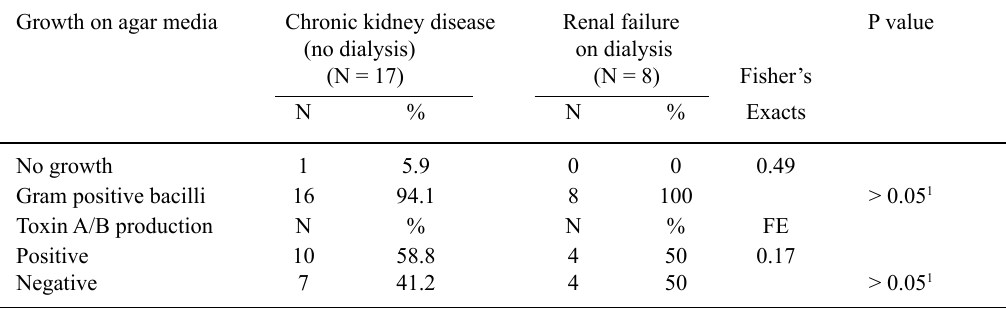
table 5. Growth on Agar medium and toxin A/B production in chronic kidney disease patients with no dialysis and renal failure patients on dialysis